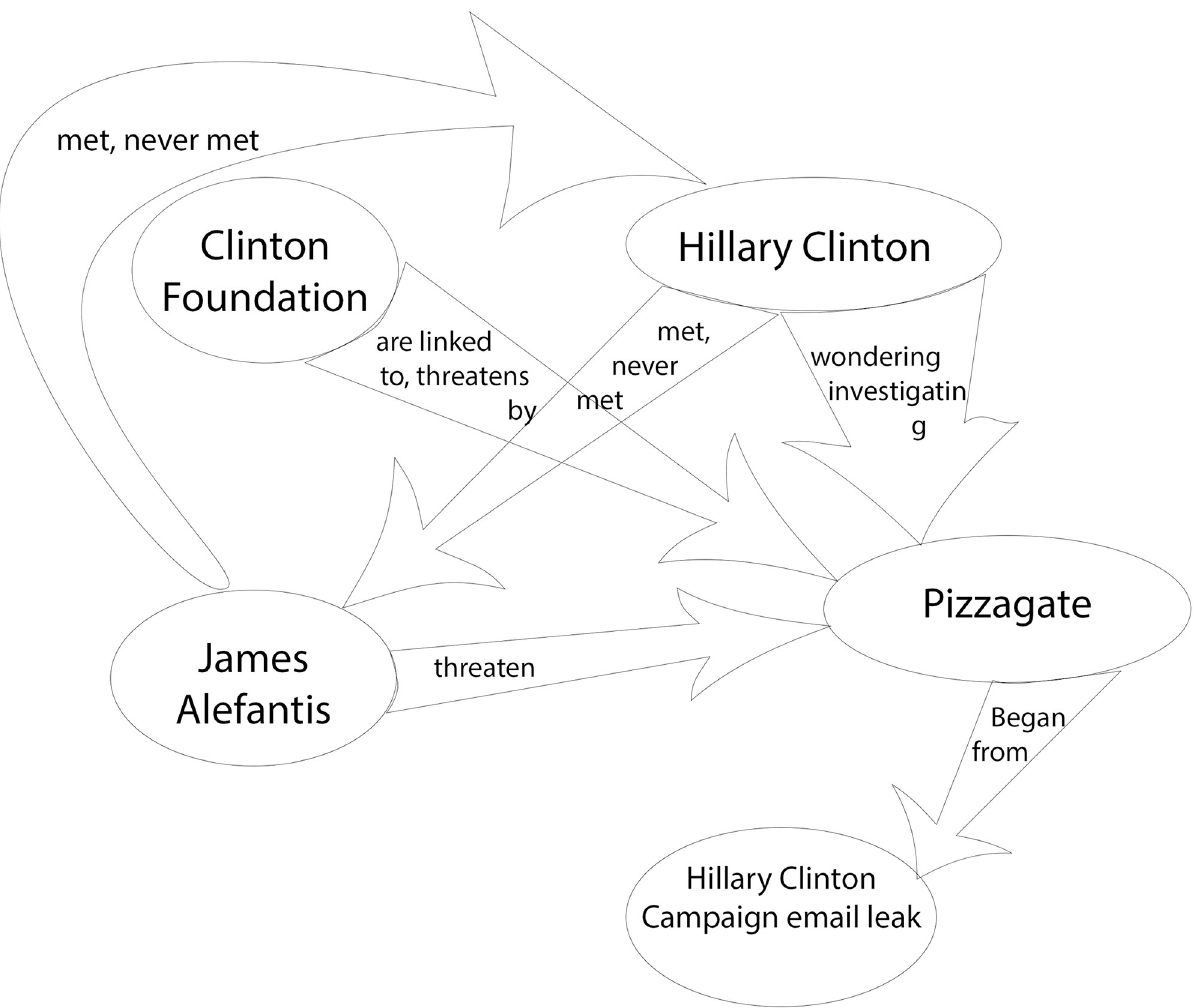
Fig 7. A subnetwork of the Pizzagate narrative framework. Some of the nodes are subnodes (e.g. “Clinton Foundation”), and others are supernodes (e.g. “Pizzagate”). Because we only pick the lead verbs for labeling edges, the contextual meaning of relationships becomes more clear when one considers the entire relationship phrase. For example, the relationship “began” connecting “Pizzagate” to “Hillary Clinton Campaign email ... .” derives from sentences such as, “ What has come to be known as Pizzagate began with the public release of Hillary Clinton campaign manager John Podesta’s emails by WikiLeaks ... ”. Similarly the edge labeled “threaten” connecting “Alefantis” to the “Pizzagate” supernode is derived from sentences such as, “ James Alefantis threatens Pizzagate researcher ... . ”. Here the supernode, “Pizzagate” includes the entity “Pizzagate researcher,” which appears as a